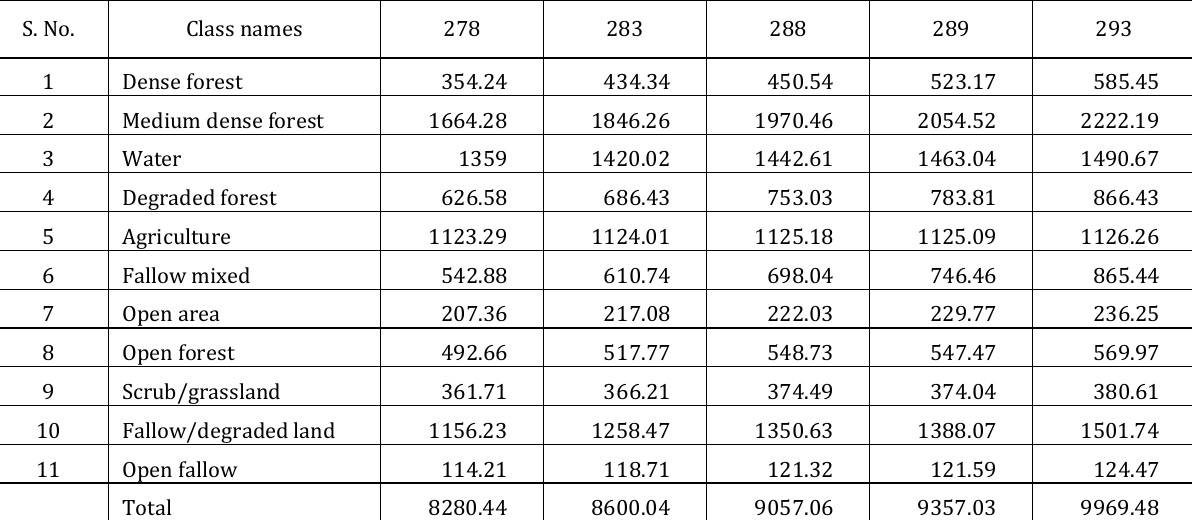
Table 3. LULC of the submergence area (in ha) at different FRL (m)